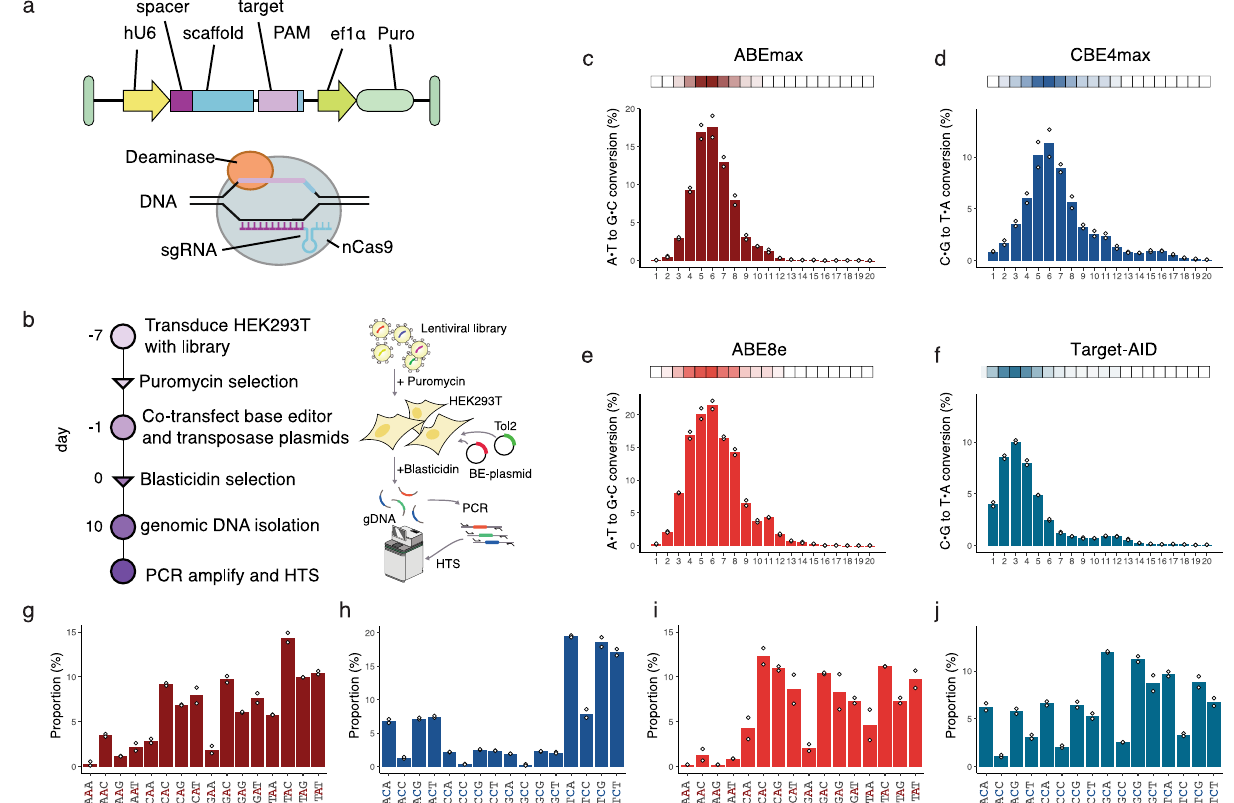
Fig. 1 A high-throughput platform for assessing base editor activities. a The design of the self-targeting library was adapted from refs. 27 – 30 . The lentiviral library contains the sgRNA expression cassette and the target locus on the same DNA molecule. The sgRNA (spacer and scaffold) is transcribed under the control of a U6 promoter and is designed to direct the base editor (nCas9-deaminase fusion) to the 20-nt sequence upstream of the protospacer adjacent motif (PAM). hU6 human U6 promoter, ef1 α elongation factor 1 α promoter, nCas9 nickase Cas9, sgRNA single-guide RNA, Puro